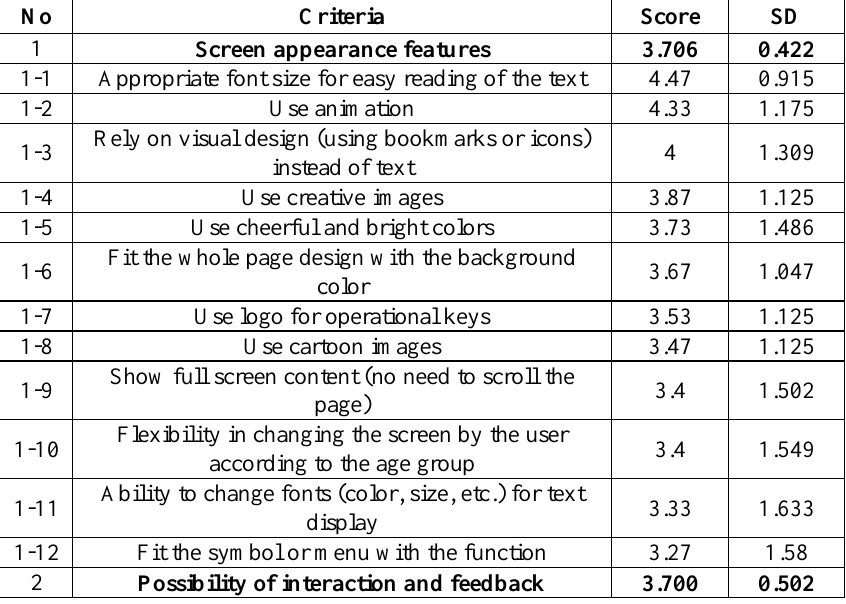
Table 7. Final ranking of suitable factors for providing services